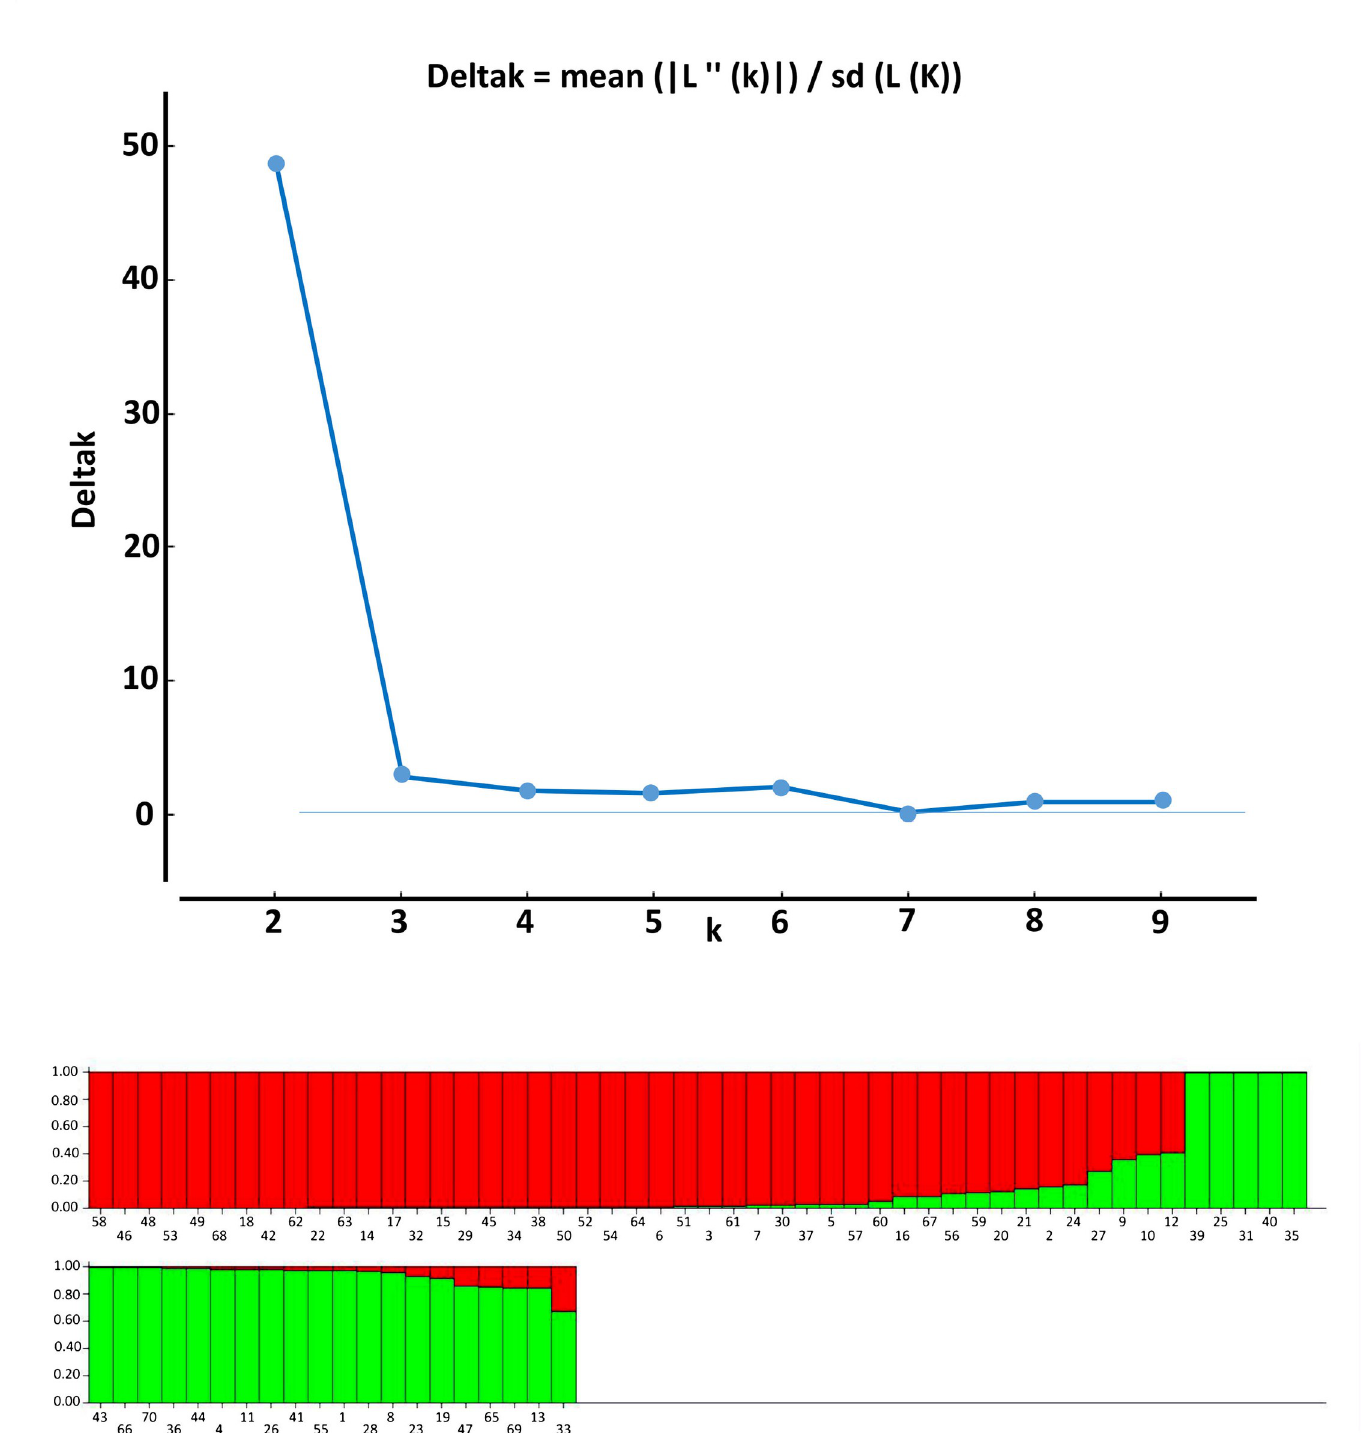
Fig 4. a. Graph of estimated membership fraction for K = 2, b. Population structure of 70 cowpea accessions (K = 2). The maximum of ad hoc measure Δ K determined by structure harvester was found to be K = 2, which indicated that the five populations could be grouped into two subgroups.